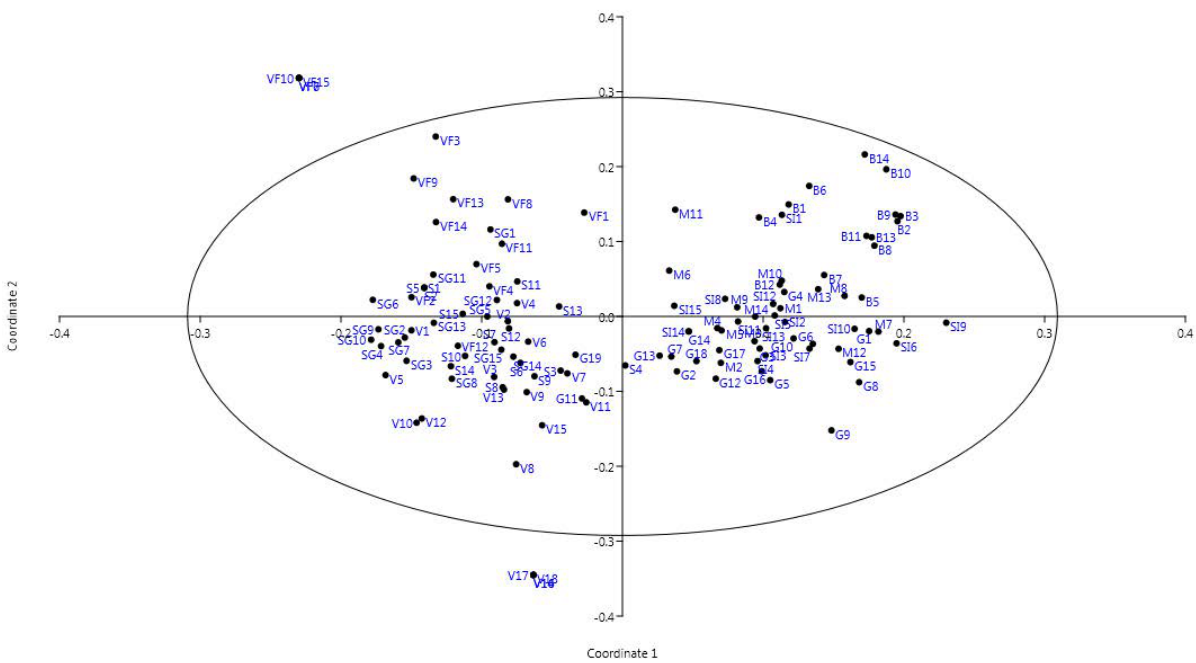
Figure 3. Principal coordinate analysis of eight populations of A. exscapus subsp. transsilvanicus based on SRAP molecular marker